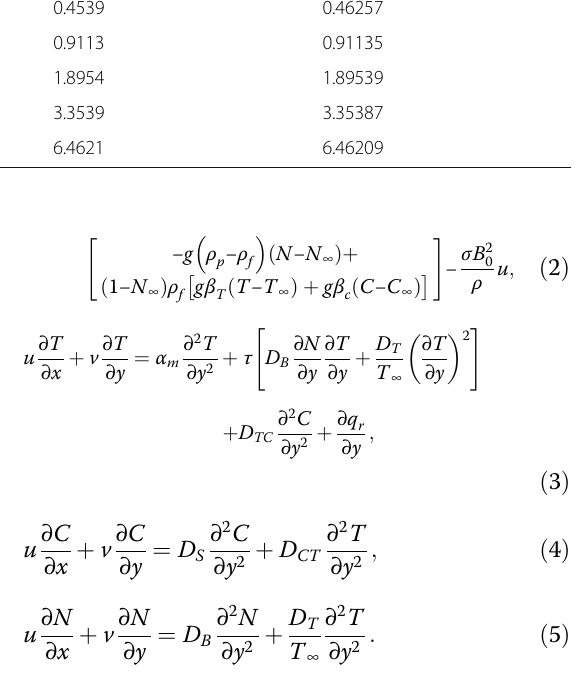
Table 1 Comparison of the result for Nusselt number − θ ′ (0) when Nd = Le = Ld = α = λ = 0, Bi = 1 , R = 1 , θ w = 1, M = 1.5 , Nc = 0.1, Ln = 0, Nb = Nt → ∞ Pr Khan and Pop (2010)